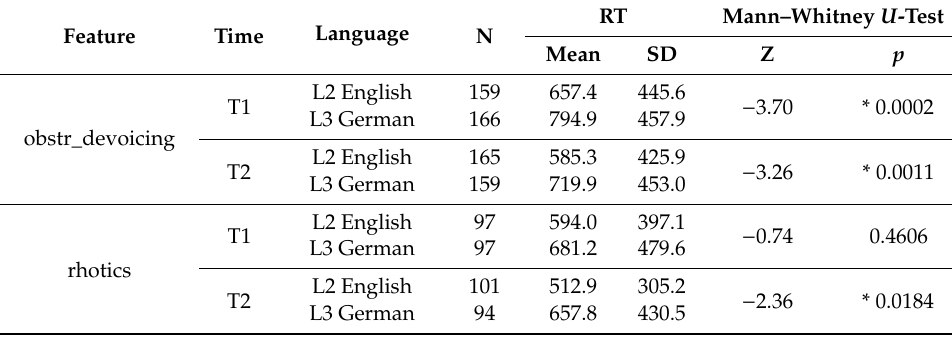
Table 8. Reaction time comparison between L2 English and L3 German.